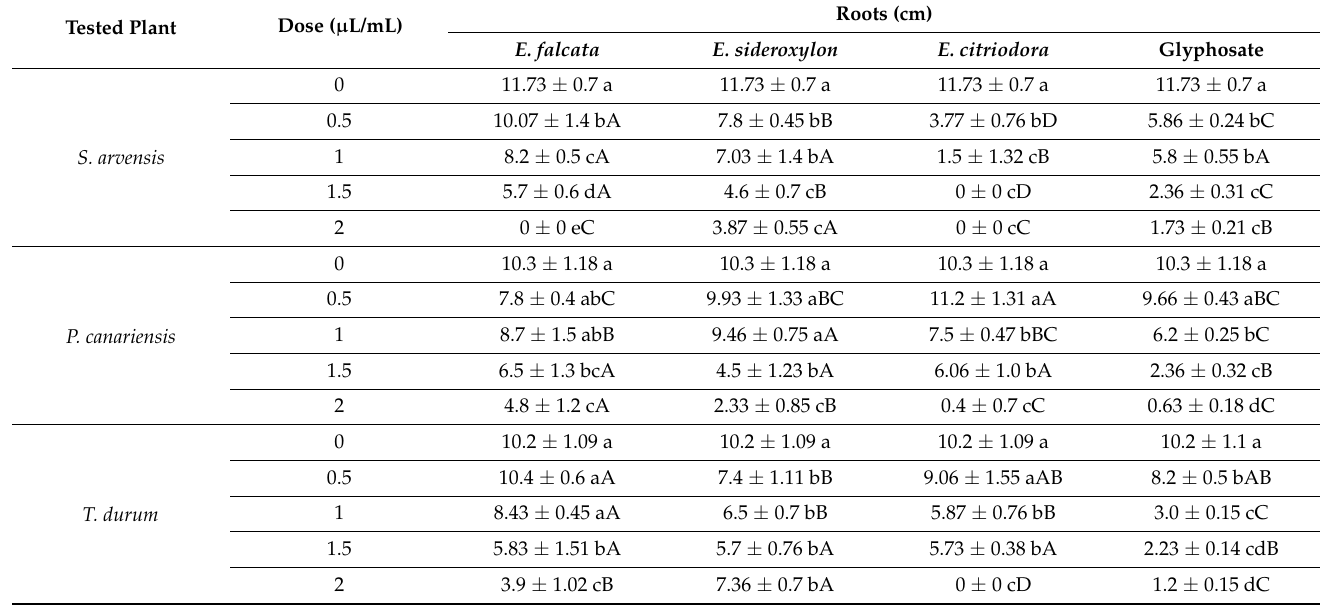
Values are means ± standard errors ( n = 3). The lowercase letters compare, in the columns, the dose effect for each herb vis- à -vis each oil. The capital letters compare, in the rows, the sensitivity of each herb at the same dose vis- à -vis the samples tested. Means followed by the same letter are not significantly different by the Student–Newman–Keuls test ( p ≤